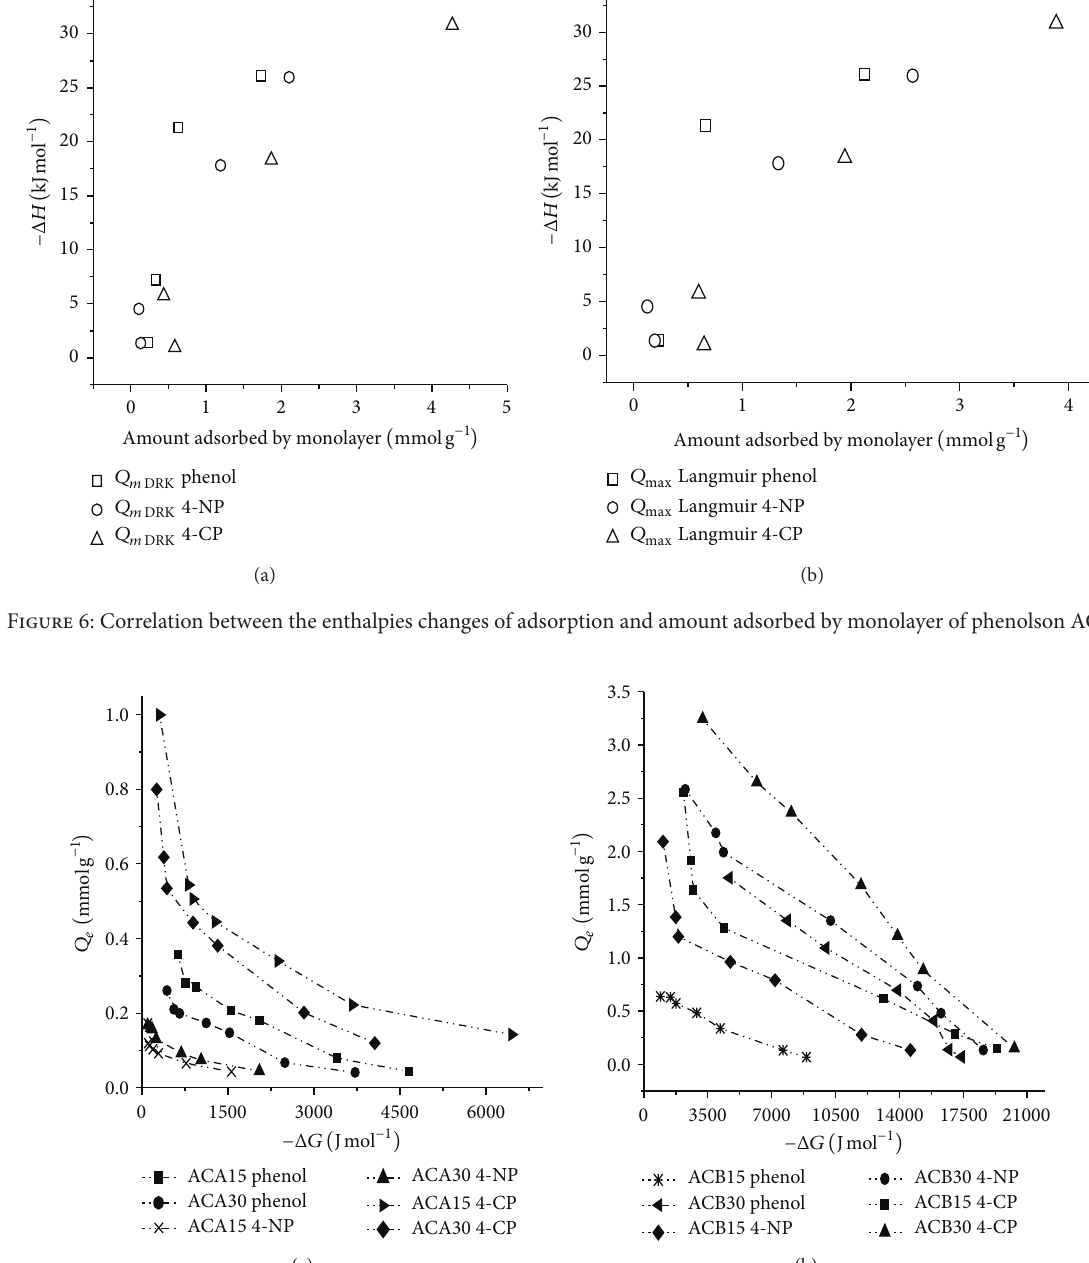
Langmuir model gives the best fitting for the adsorption isotherm in most